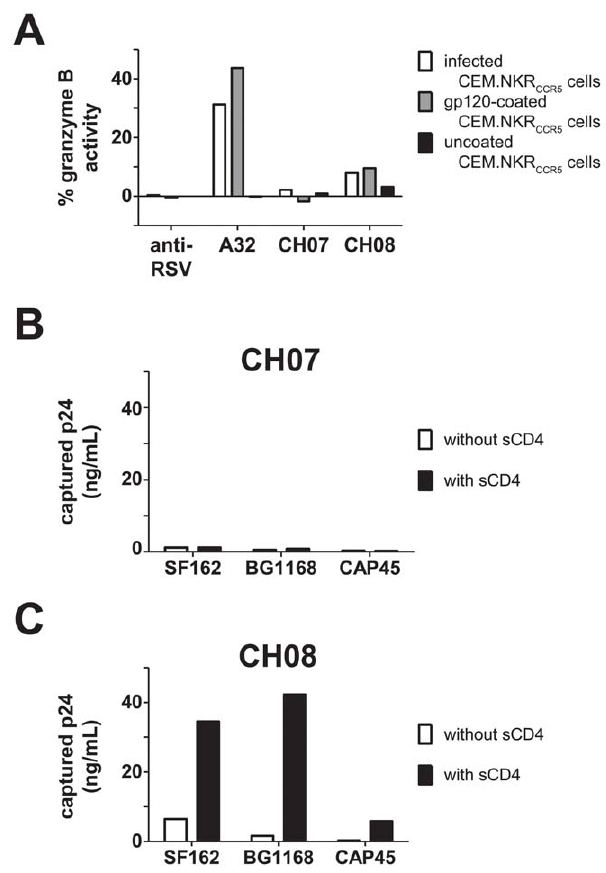
Figure 3. ADCC and virus capture by mAbs CH07 and CH08. A. CH07 and CH08 were tested for ADCC activity compared with anti-RSV mAb (Palivizumab) and A32. CH07 did not mediate ADCC, while both A32 and CH08 stimulated granzyme B activity NK effector cells when reacted with infected and gp120-coated targets. Each bar represents the percent of target cells containing granzyme B. B. CH07 did not capture pseudoviruses SF162.B, BG1168.B, and CAP45.C. Data shown as p24 released from captured virus. C. CH08 captured all three pseudoviruses in the presence of sCD4 but not when sCD4 was absent. Data shown as p24 released from captured